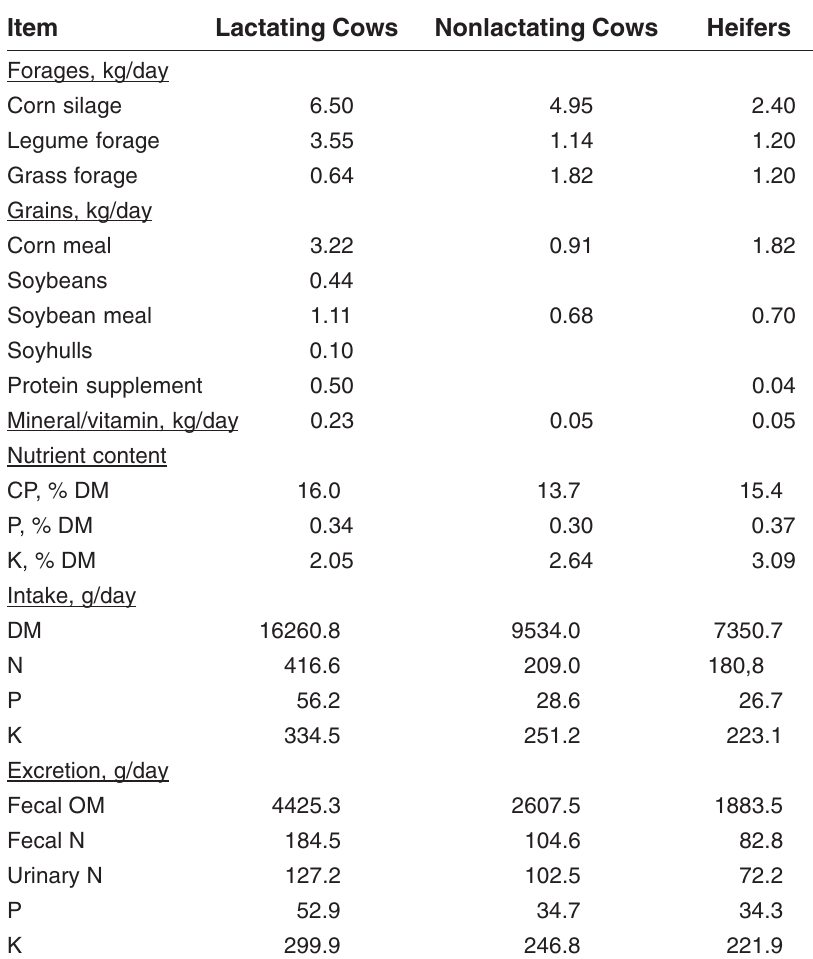
Mean Intake and Excretion of Dry Matter for Ration Ingredients Per Animal Per Day for Three